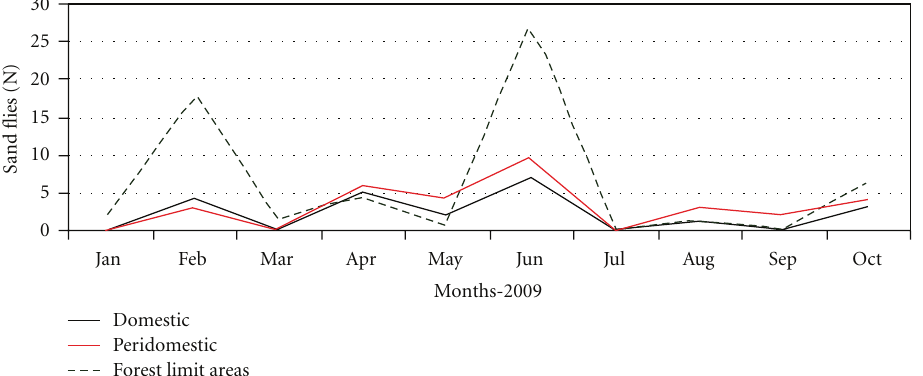
Figure 3: Monthly capture of sand flies vectors in domestic, peridomestic and forest limit areas of house 2, January to October